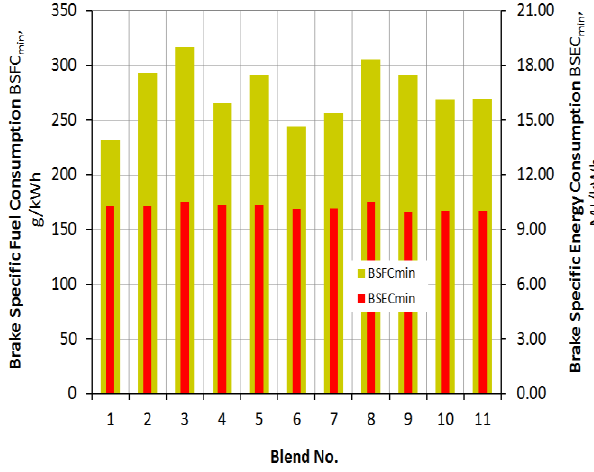
Fig. 3. BSFC min (higher bars – in yellow) and BSEC min (lower bars – red) vs. mixtures